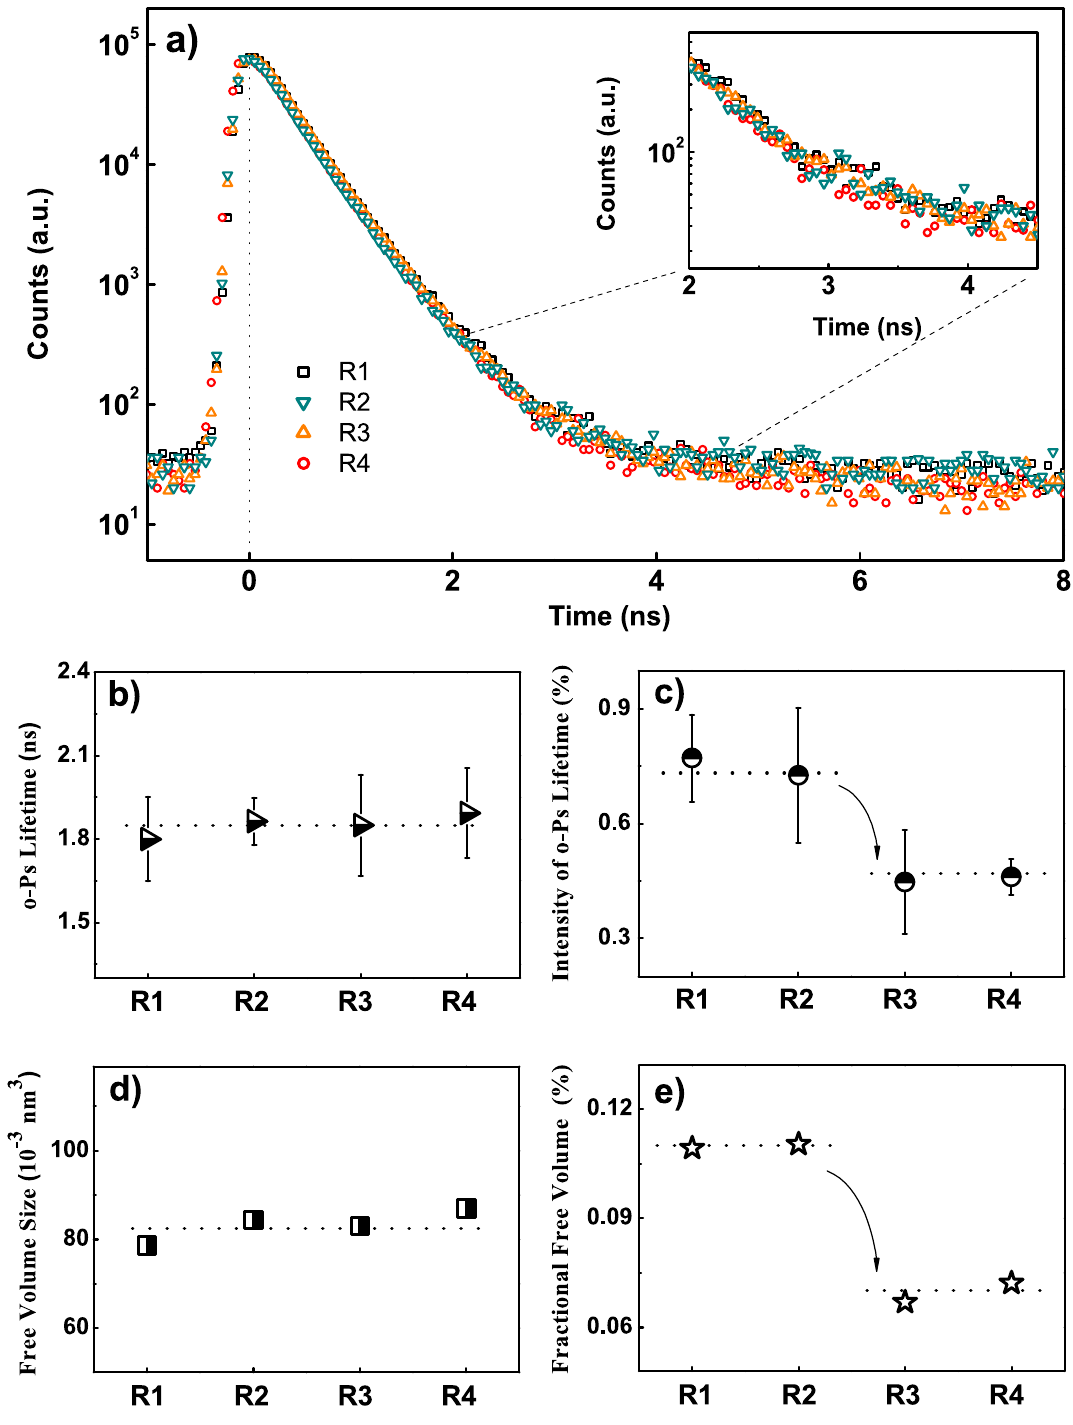
Figure 7. ( a ) Raw positron lifetime spectra of samples; The variations in ( b ) o-Ps lifetime ( τ o − Ps ), ( c ) the intensity (I o − Ps ), ( d ) the sizes of free volumes (V FV ) obtained by using the Tao-Eldrup model, and ( e ) the fractional free volume (FFV) of the rice basal culm. Arrows and dotted lines are guides to the